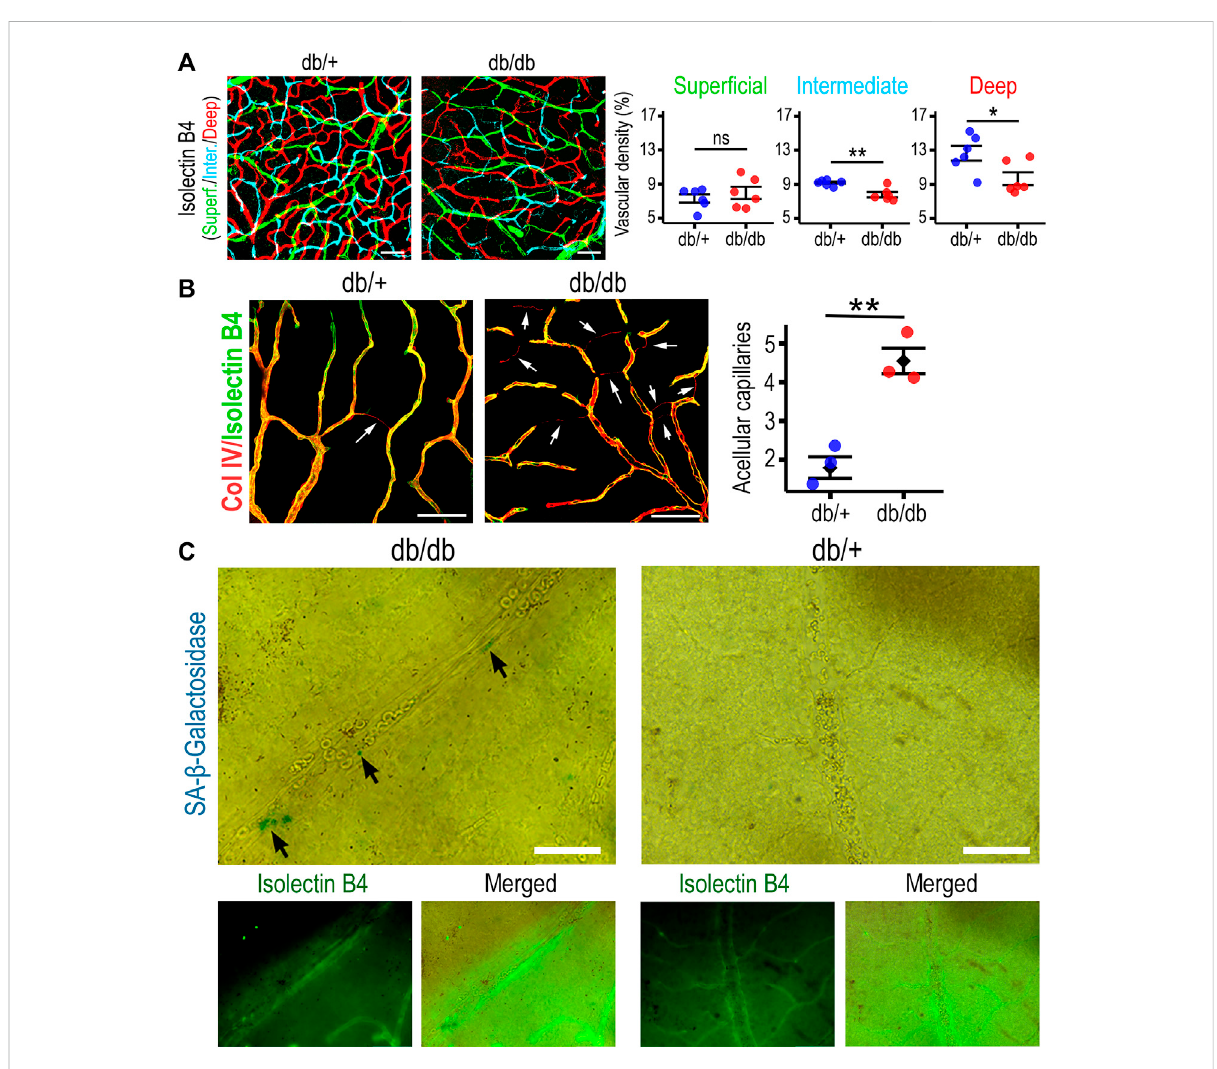
FIGURE 4 Db/db retinas exhibit vascular attrition and accumulation of senescent cells in vasculature. (A) Retinal tissue from 6 – 9-months mice stained with Isolectin B4 to identify vasculature, and pseudocolored based on confocal sections to distinguish three retinal plexuses; super fi cial shown in green,intermediateincyan,anddeepinred.Vasculardensitywasassessedaspercentageoftotalarea.** p < 0.01,* p < 0.05,ns:notsigni fi cant.Two- tailed paired t-test was used for analysis. (B) Retinas were stained with antibody against Collagen IV (Red) and with Isolectin B4 (Green) to identify acellular capillaries and compared their frequency in non-diabetic to diabetic. ** p < 0.01. (C) Retinas were stained with SA- β -Galactosidase toidentifysenescentcellsbythebluestaining.CounterstainingwithIsolectinB4ingreentoshowsenescentcellswithintheretinalvasculature.Scale bars: 50